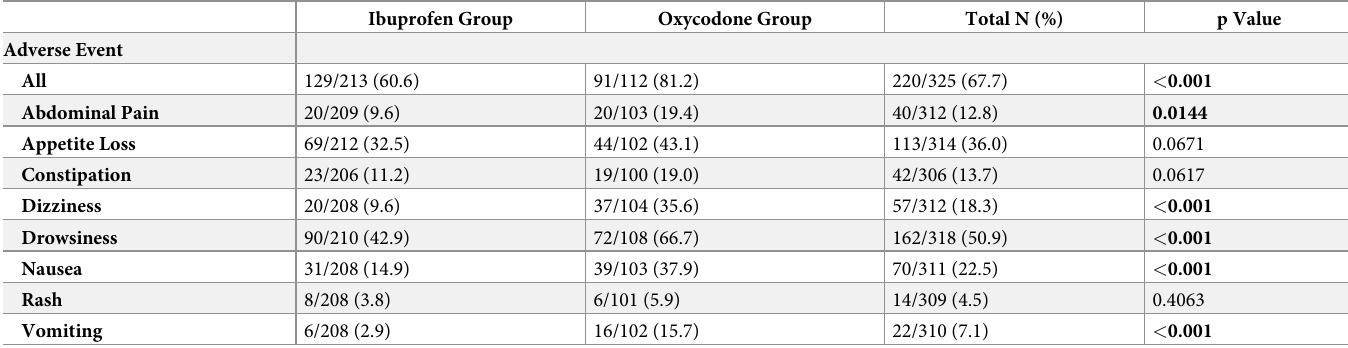
Table 4. Cumulative adverse events (Days 1–3) by study